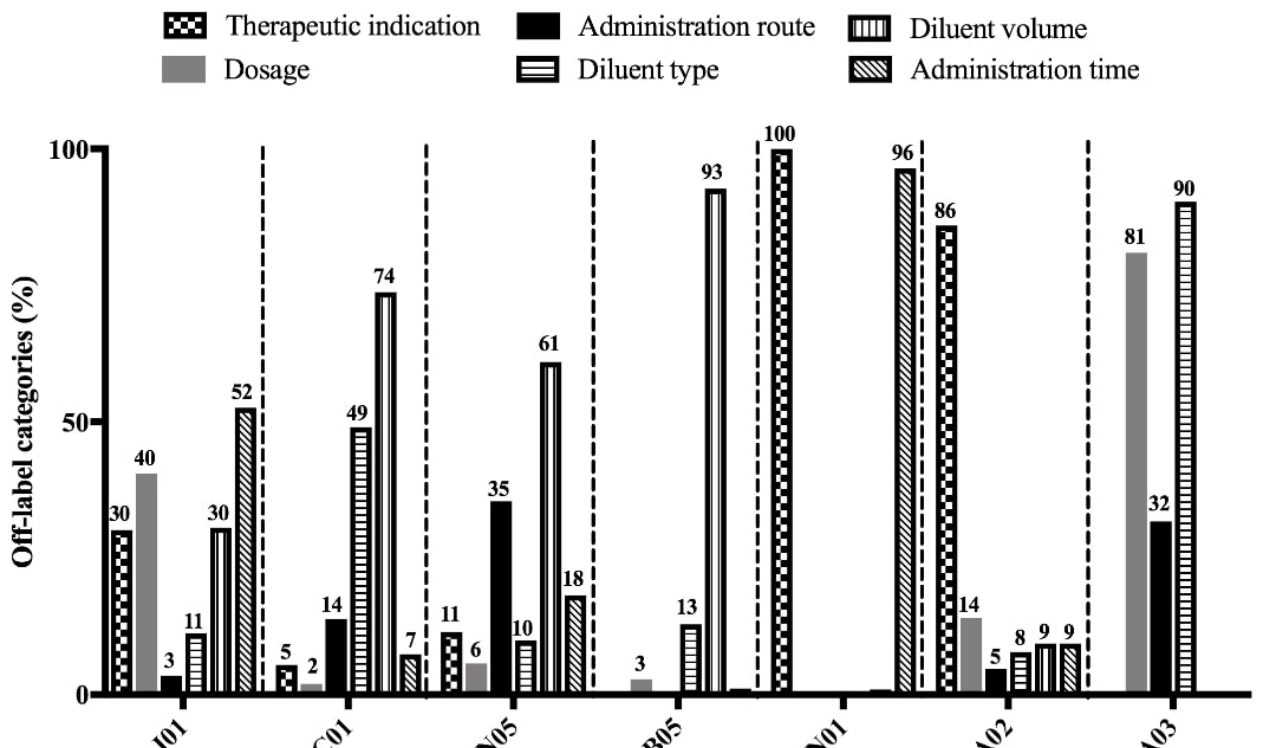
FIGURE 3 - Prevalence of off-label drug use categories by therapeutic class according to the ATC classification.